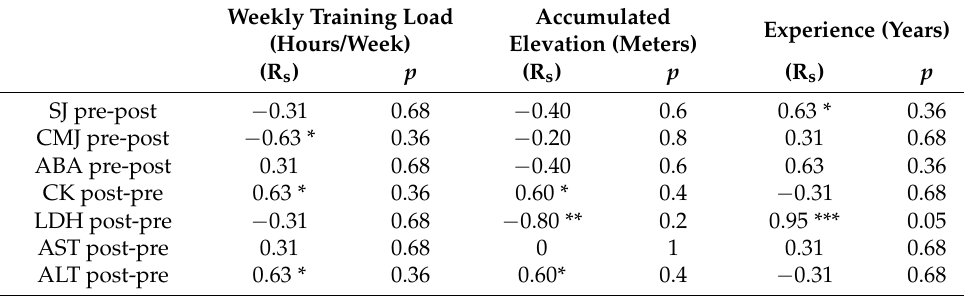
Table 6. Spearman’s rank correlation coefficient (R s ) and probability ( p ). Weekly Training Load Accumulated (Hours/Week) Elevation